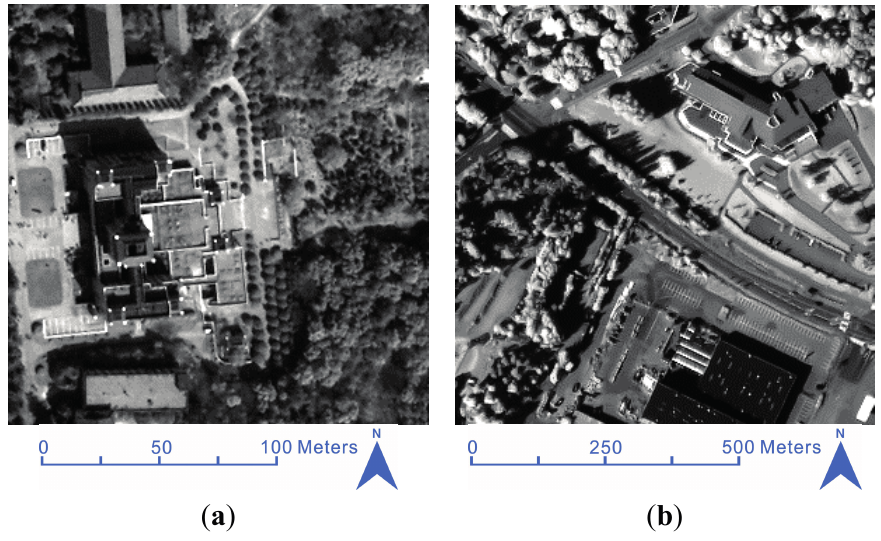
Figure 4. Preprocessed test images in the simulated experiments: ( a ) the QuickBird image; ( b ) the SPOT